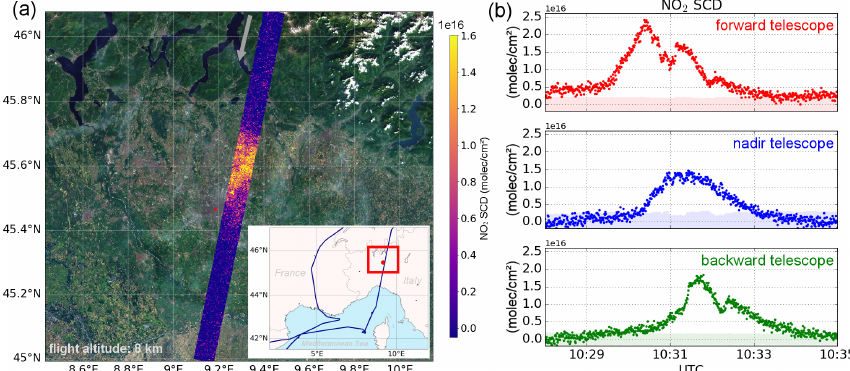
Figure 18. HAIDI measurement at 8km altitude of the Milan outflow during E-EU-09: (a) pixel-resolved NO 2 slant column densities observed by the nadir camera (marked by the red square on the map). The grey arrow indicates the direction of the flight. An enhancement of up to 1 . 5 × 10 16 moleccm − 2 over the background is observed northeast of Milan (red-coloured circle), (b) NO 2 slant column densities averaged over the whole swath for all three telescopes: forward (top) nadir (middle) and backward (bottom). The height of the plume centre is estimated from the time difference of the maxima. Sources of background imagery: ESRI, DigitalGlobe, GeoEye, i-cubed, USDAFSA, USGS, AEX, Getmapping, Aerogrid, IGN, IGP, swisstopo, and the GIS User